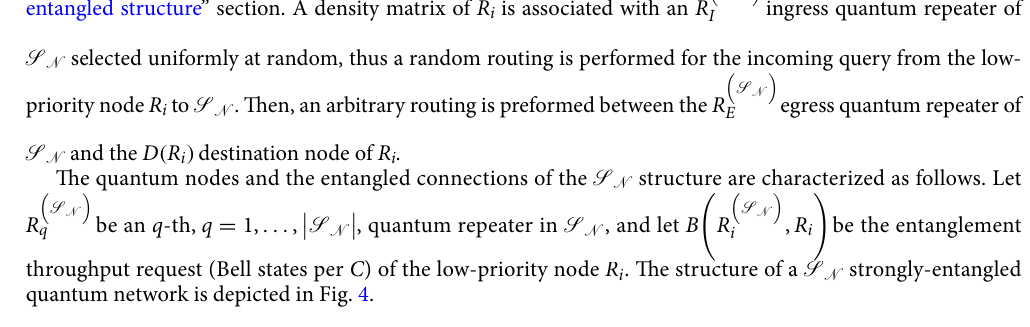
throughput request (Bell states per C ) of the low-priority node R i . The structure of a S N strongly-entangled quantum network is depicted in Fig. 4.